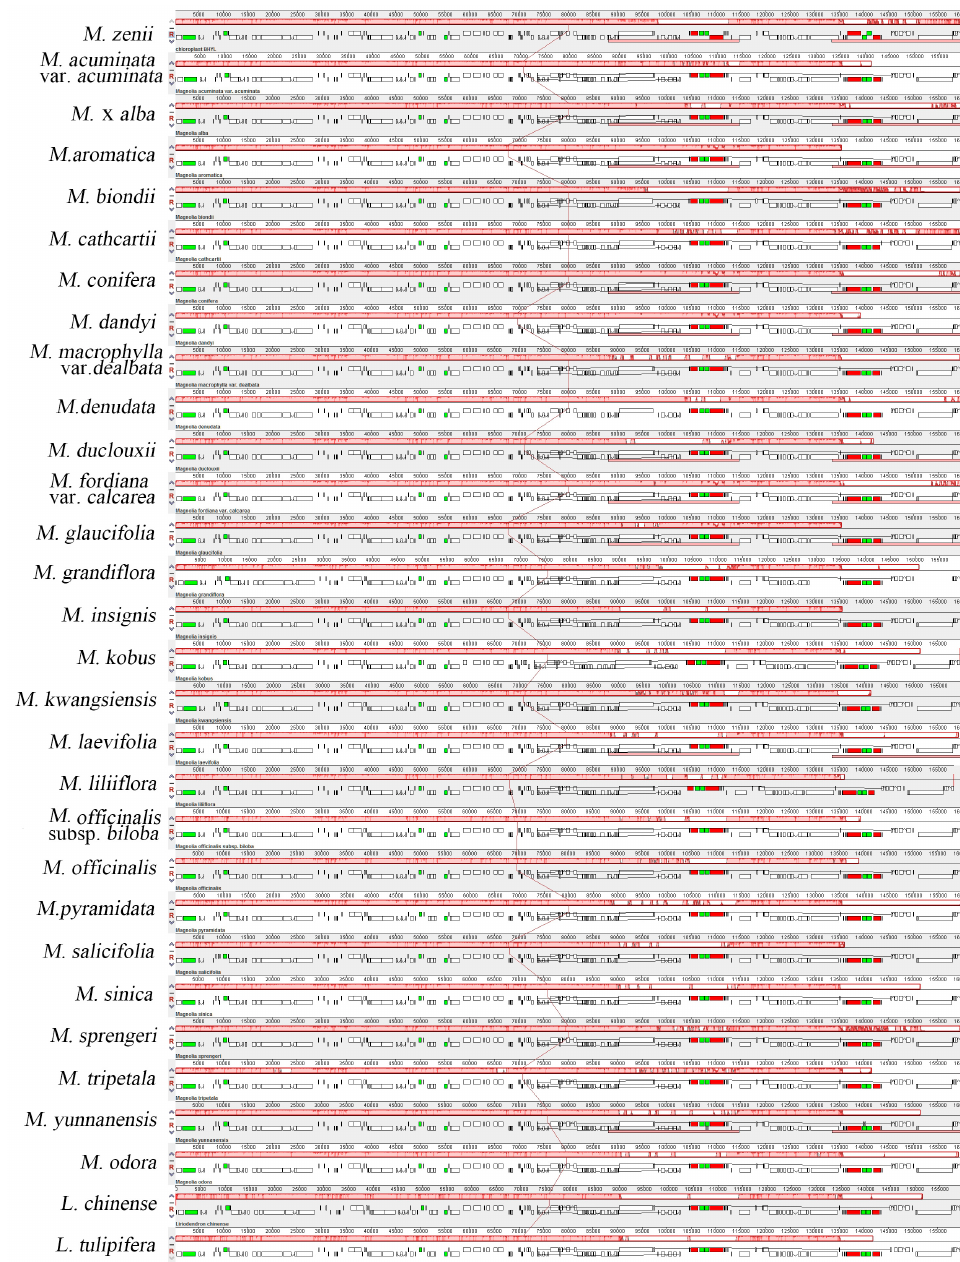
Figure 2. Mauve (Multiple Alignment of Conserved Genomic Sequence With Rearrangements) [47] alignment of plastid genomes of 28 species of Magnolia and two species of Liriodendron . The M. zenii genome is shown at the top as the reference genome. Within each of the alignments, local collinear blocks are represented by blocks of the same color connected by lines.